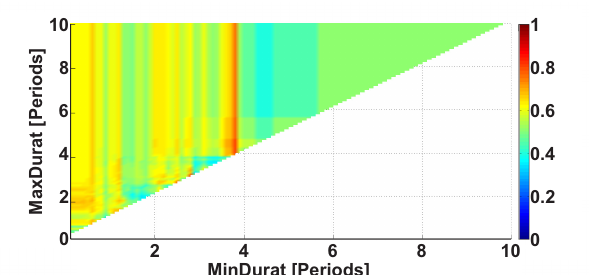
Figure 9. An example of the Duration AUC diagram. The abscissa axis is the lower bound of the dura- tion range in periods; the ordinate axis is the upper bound of the duration range in periods. A narrow bright orange area is situated along the ordinate axis; the x-coordinate is equal to approximately 3.8 periods.